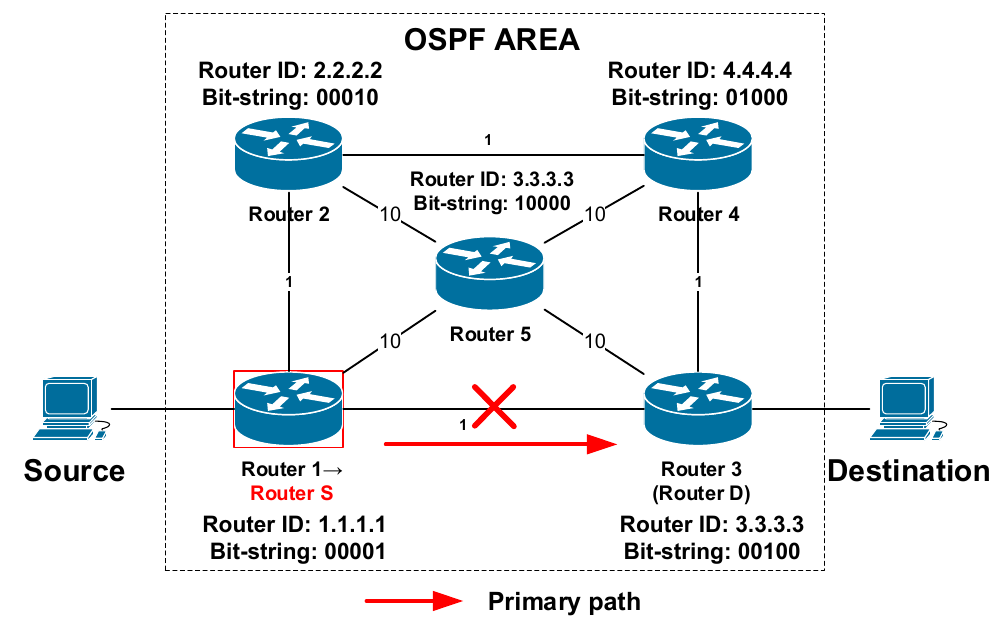
Figure 7. Detection of a failure and the reaction of the B-REP